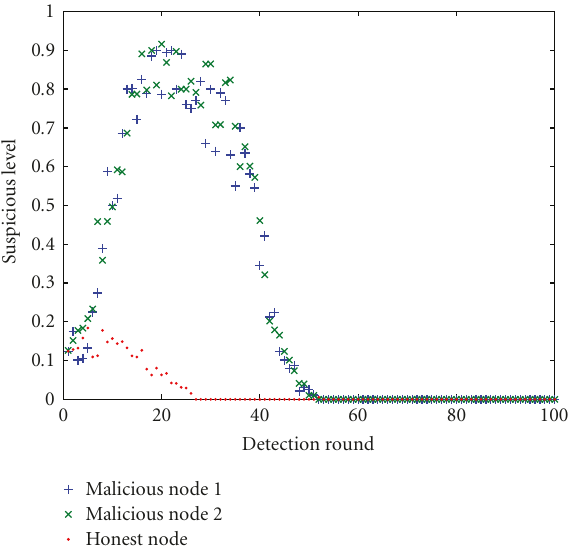
Figure 13: Dynamic suspicious level in proposed scheme (two malicious nodes perform FA attack during time [5,15]).